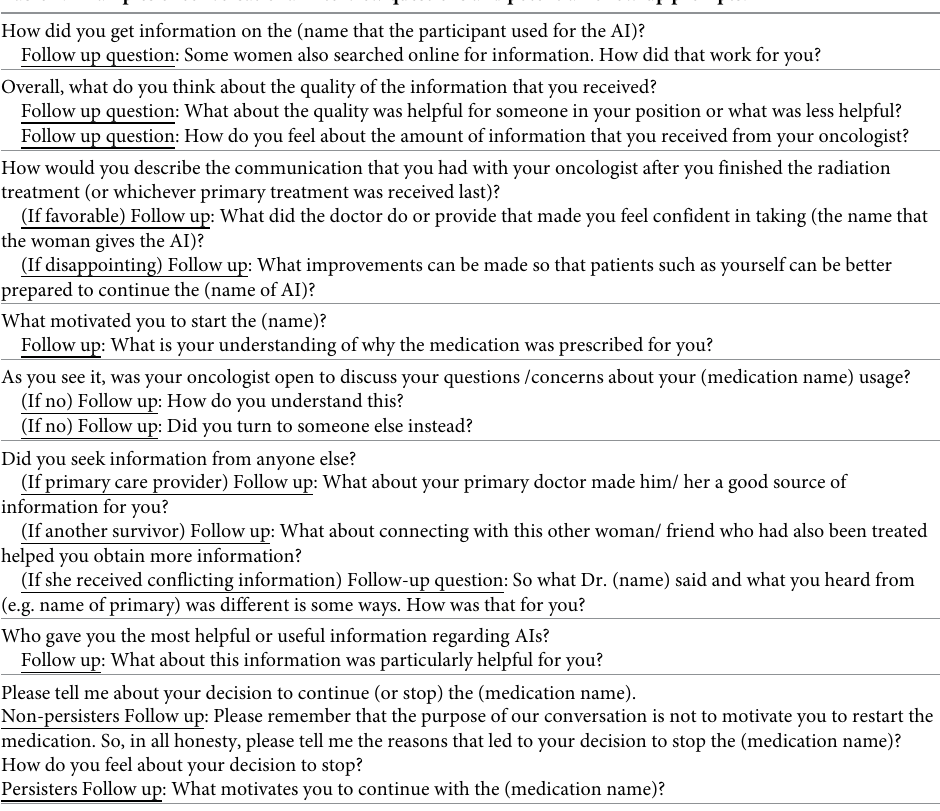
Table 1. Examples of conversational interview questions and potential follow-up